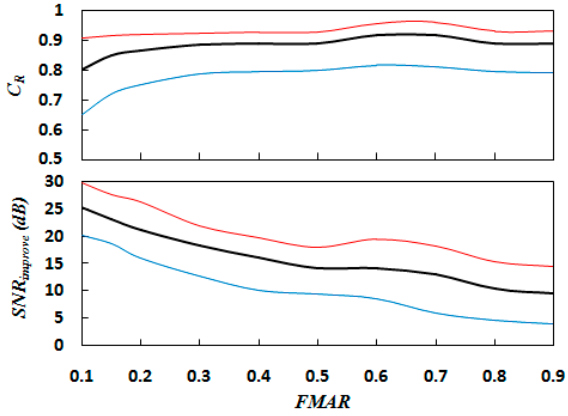
Figure 8. Correlation coefficient and SNR improvement results against the FECG and MECG amplitude ratio ( FMAR ) using the proposed method for 105 synthetic signals. The red, blue, and black lines present the maximum, minimum, and average values, respectively.